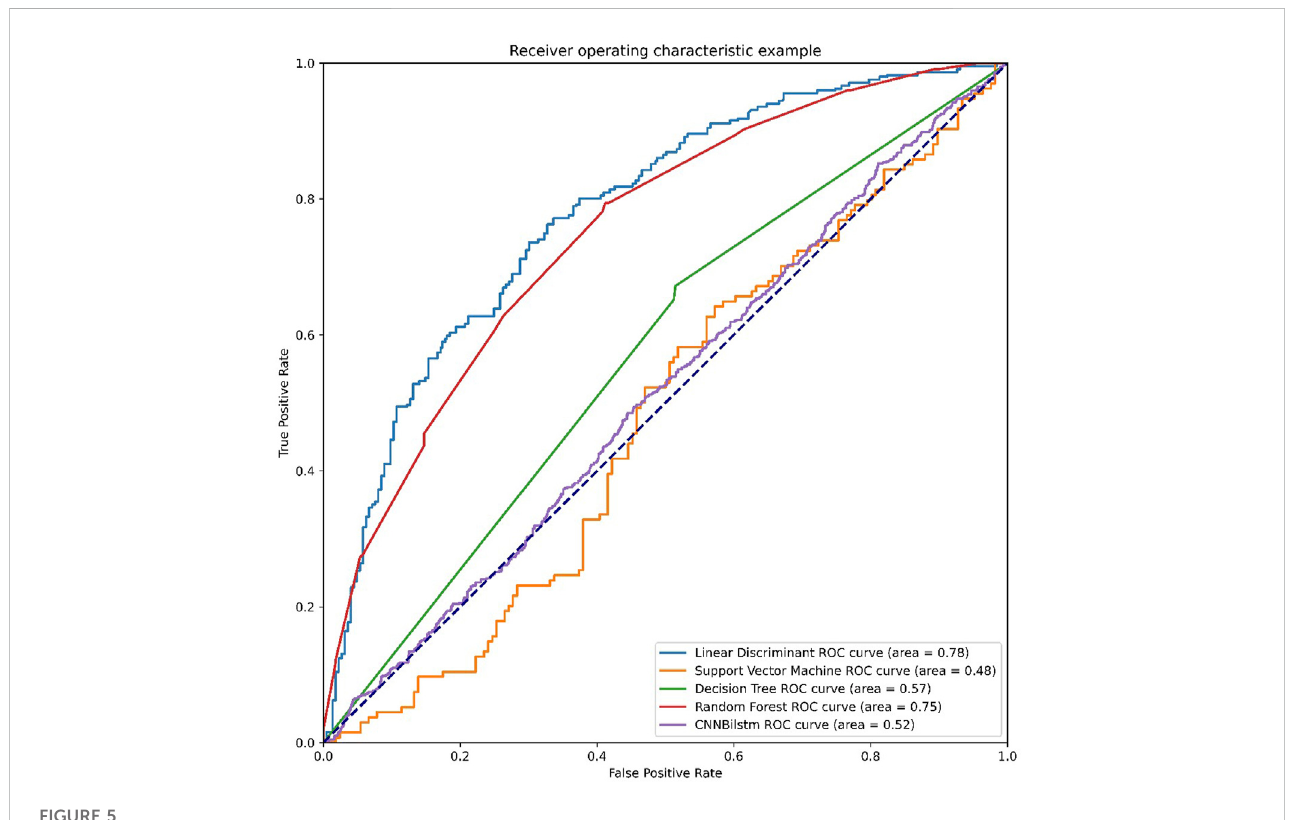
FIGURE 5 The ROC curves of DPC feature.